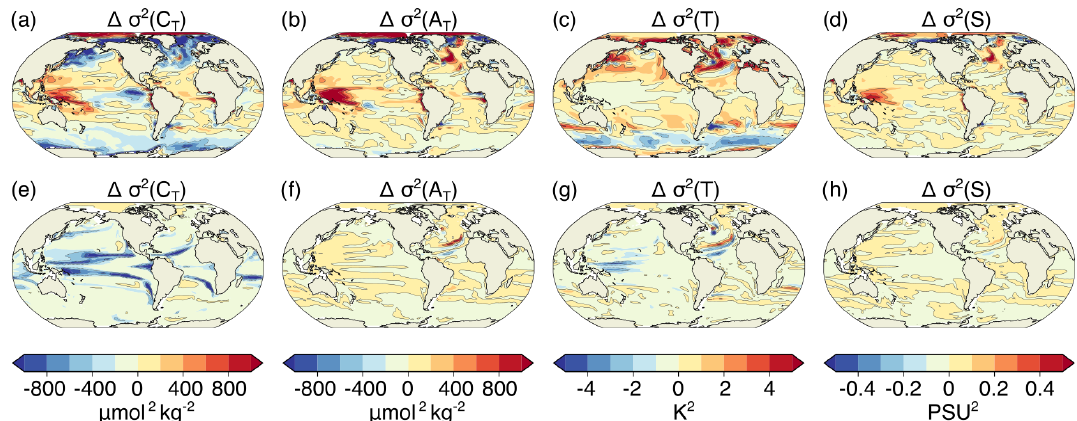
Figure A6. Simulated ensemble-mean changes in the variances of C T (a, e) , A T (b, f) T (c, g) , and S (d, h) from the preindustrial period to 2081–2100 under the RCP8.5 scenario. Shown are changes for (a–d) the surface and (e–h) at 200m. The black contours highlight the pattern